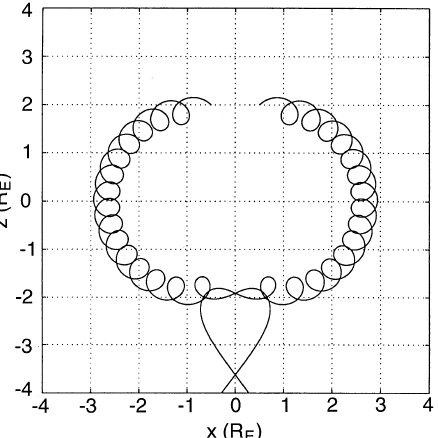
Fig. 3. Planar meridional trajectories of a proton (500 keV) in a symmetric sectorial quadrupole magnetic field ( m (cid:136) 2, n (cid:136) 2;